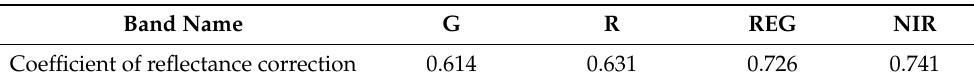
Table 8. Sentinel-2A satellite imagery reflectance correction coefficient for each